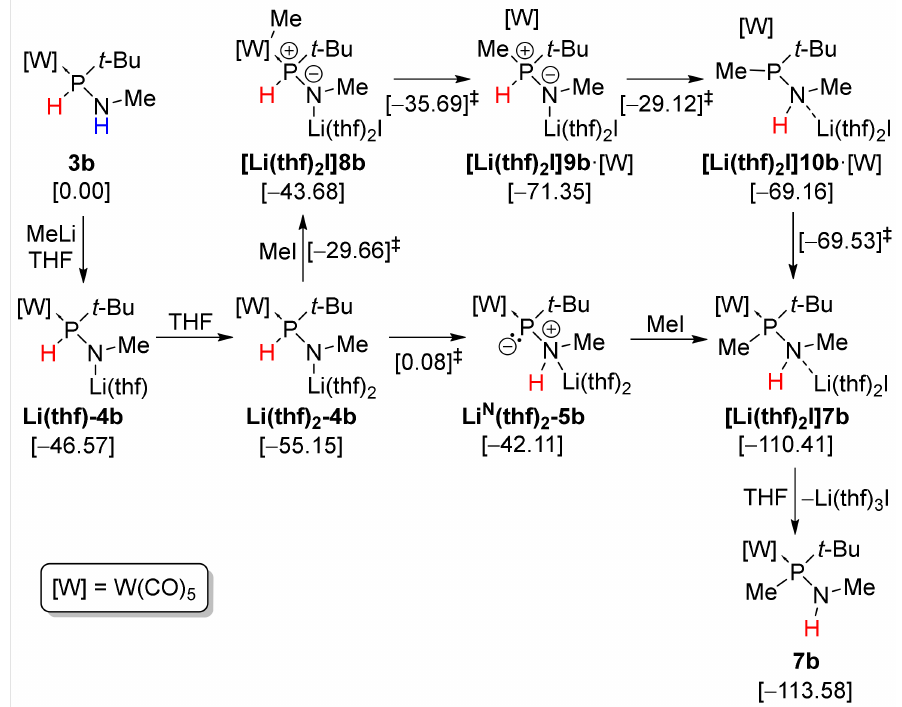
complex 3d ; Figure S5: NMR spectra of complex 3e ; Figure S6: NMR spectra of complex 3f in product mixture; Figure S7: NMR spectra of compound Li-4b in product mixture; Figure S8: NMR spectra of compound Li-5b in reaction mixture; Figure S9: NMR spectra of compound K-5b in reaction mixture; Figure S10: NMR spectra of compound 7 in product mixture; Figure S11: Decomposition of Li-5b in THF solution on warming up from − 80 ◦ C; Figure S12: NMR spectra measured for the reaction of 3b with MeLi in presence of 12-crown-4 and n -BuLi, followed by treatment with MeI; Cartesian coordinates and energies for all computed species; Table S1: Computed 31 P chemical shifts (in